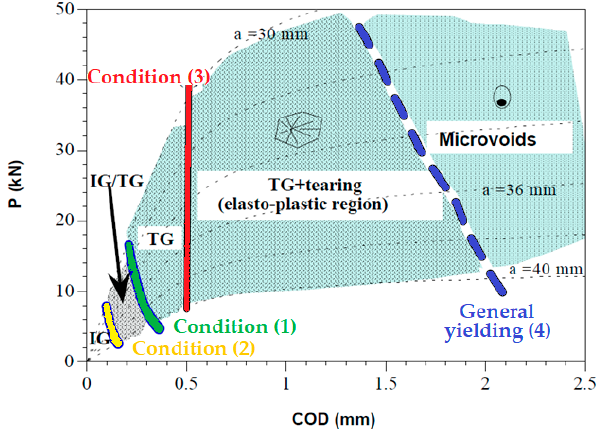
Figure 3. Modeling of the different behavior zones in the load displacement (P-COD) curve [5].